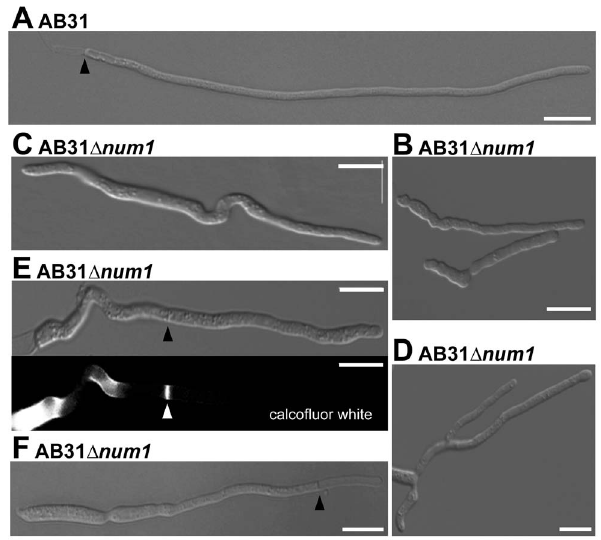
Figure 1. Num1 is required for polar growth and septum formation. Filament formation of AB31 wild-type and AB31 D num1 deletion strains was monitored 12–14 hours upon induction of the bE1/ bW2 heterodimer. ( A ) AB31 wild-type cells grow as long, straight filaments; only the tip compartment is filled with cytoplasm, separated from highly vacuolated distal compartments by a septum (arrowhead). ( B ) AB31 D num1 hyphae grow shorter and more curved. In AB31 D num1 , bipolar ( C ) and branched ( D ) hyphae are observed frequently. ( E ) Septa of AB31 D num1 are often formed within the compartment filled with cytoplasm (arrowheads denote delocalized septum; in lower panel, Calcofluor White staining was used to visualize the septum). ( F ) In approx. 2.5% of hyphae delocalized septa (arrowhead) lead to empty tip